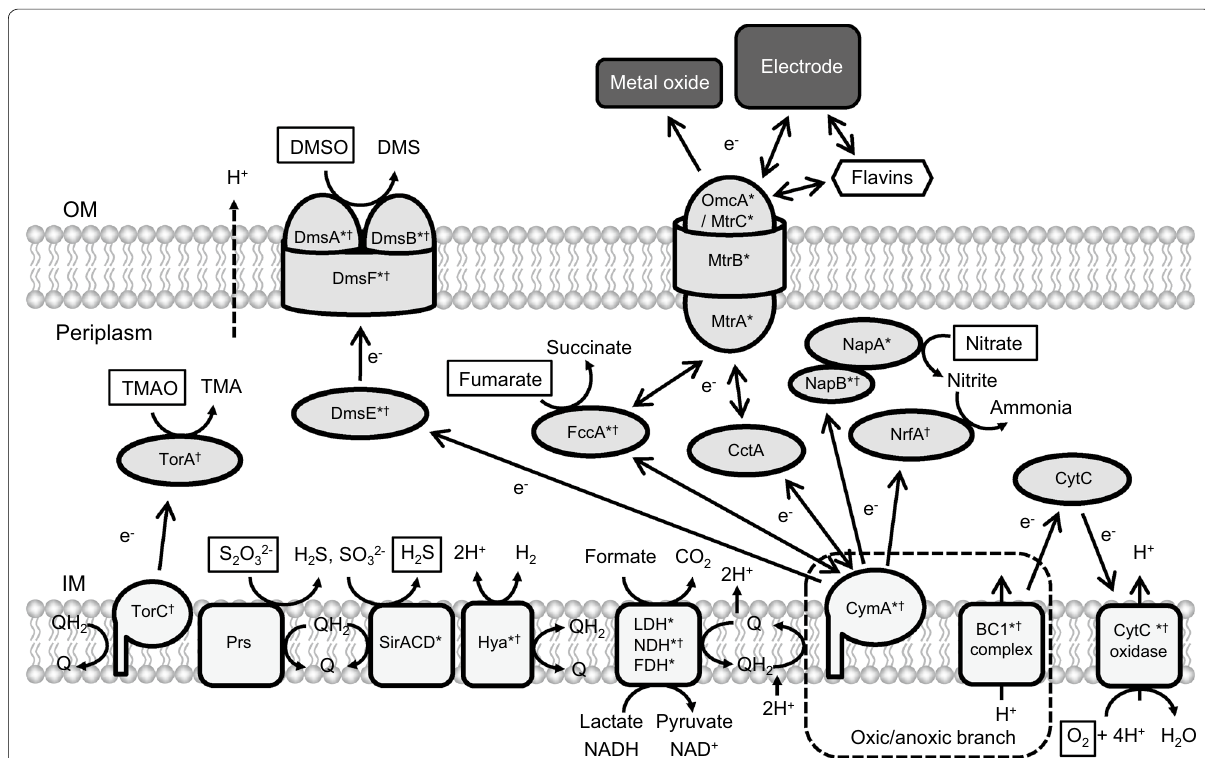
Fig. 2 Electron-transport pathways in S. oneidensis MR-1. Electron acceptors are marked with boxes. *Enzymes whose gene expression is regulated by the Arc system (Gao et al. 2008); † enzymes whose gene expression is regulated by the cAMP/CRP system (Charania et al. 2009). OM: outer membrane; IM: inner membrane; TMAO: trimethylamine N -oxide; TMA: trimethylamine; DMSO: dimethyl sulfoxide; DMS: dimethyl